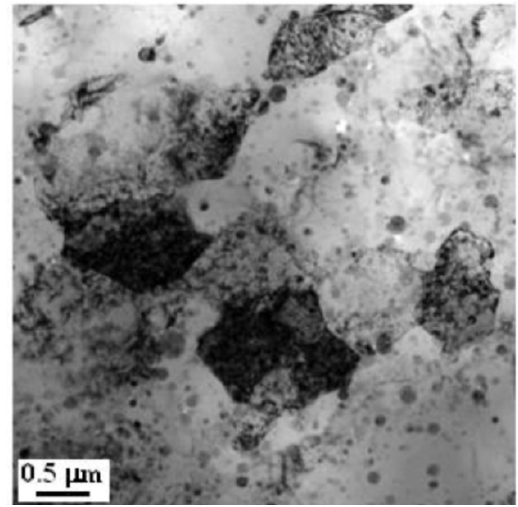
O nanoparticles (<50 nm in sizes) in the Al matrix 2 3